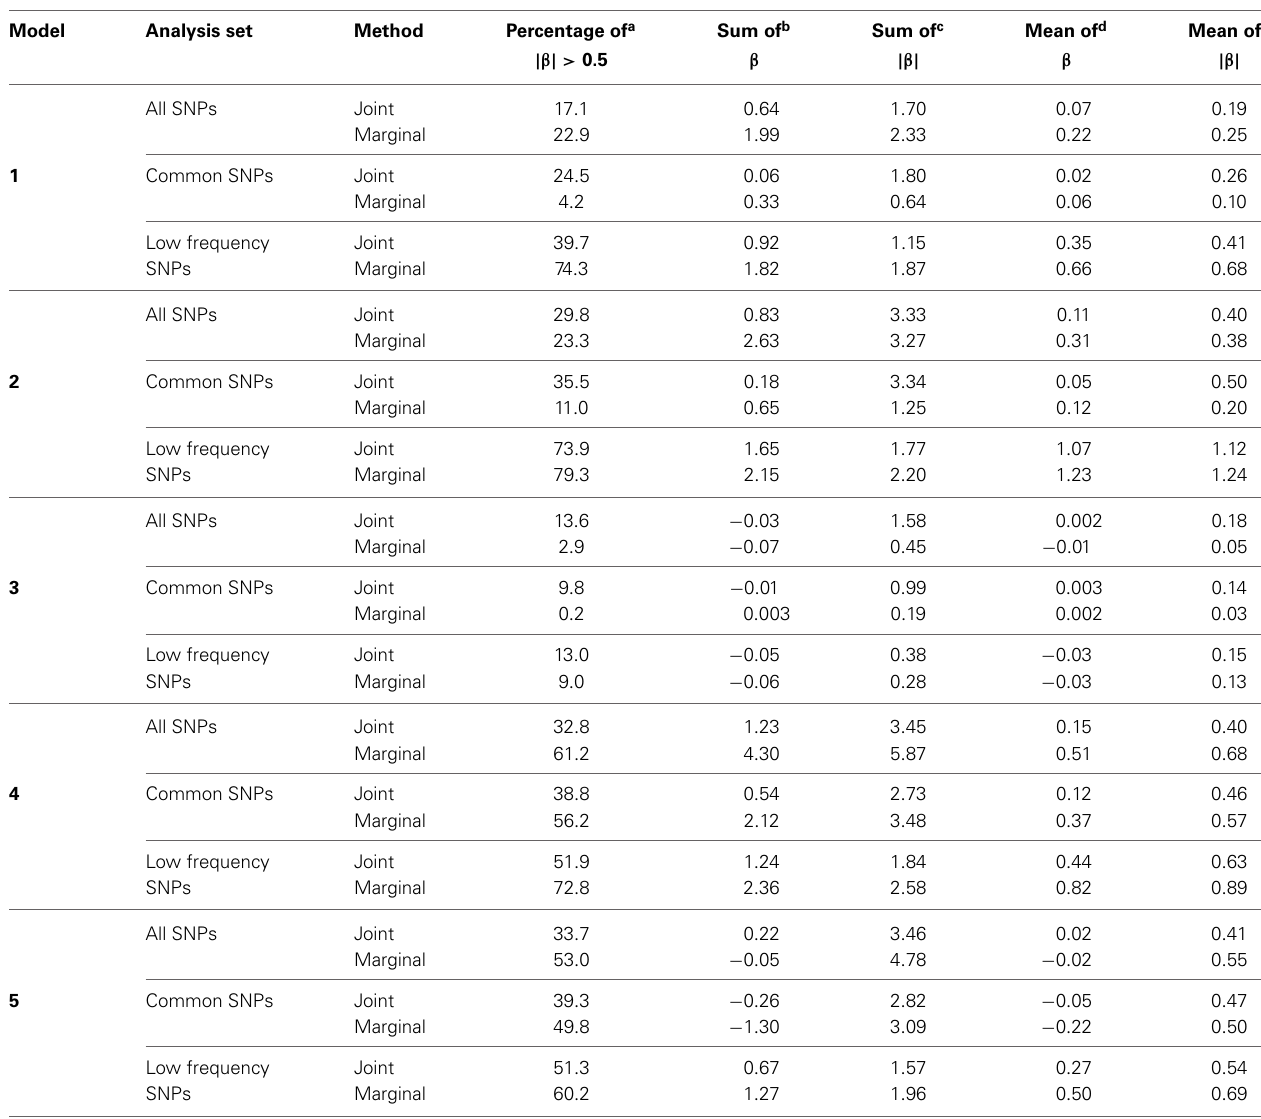
Table 3 | Summary of expected beta coefficients for joint and marginal regression analysis using three analysis sets averaged over 85